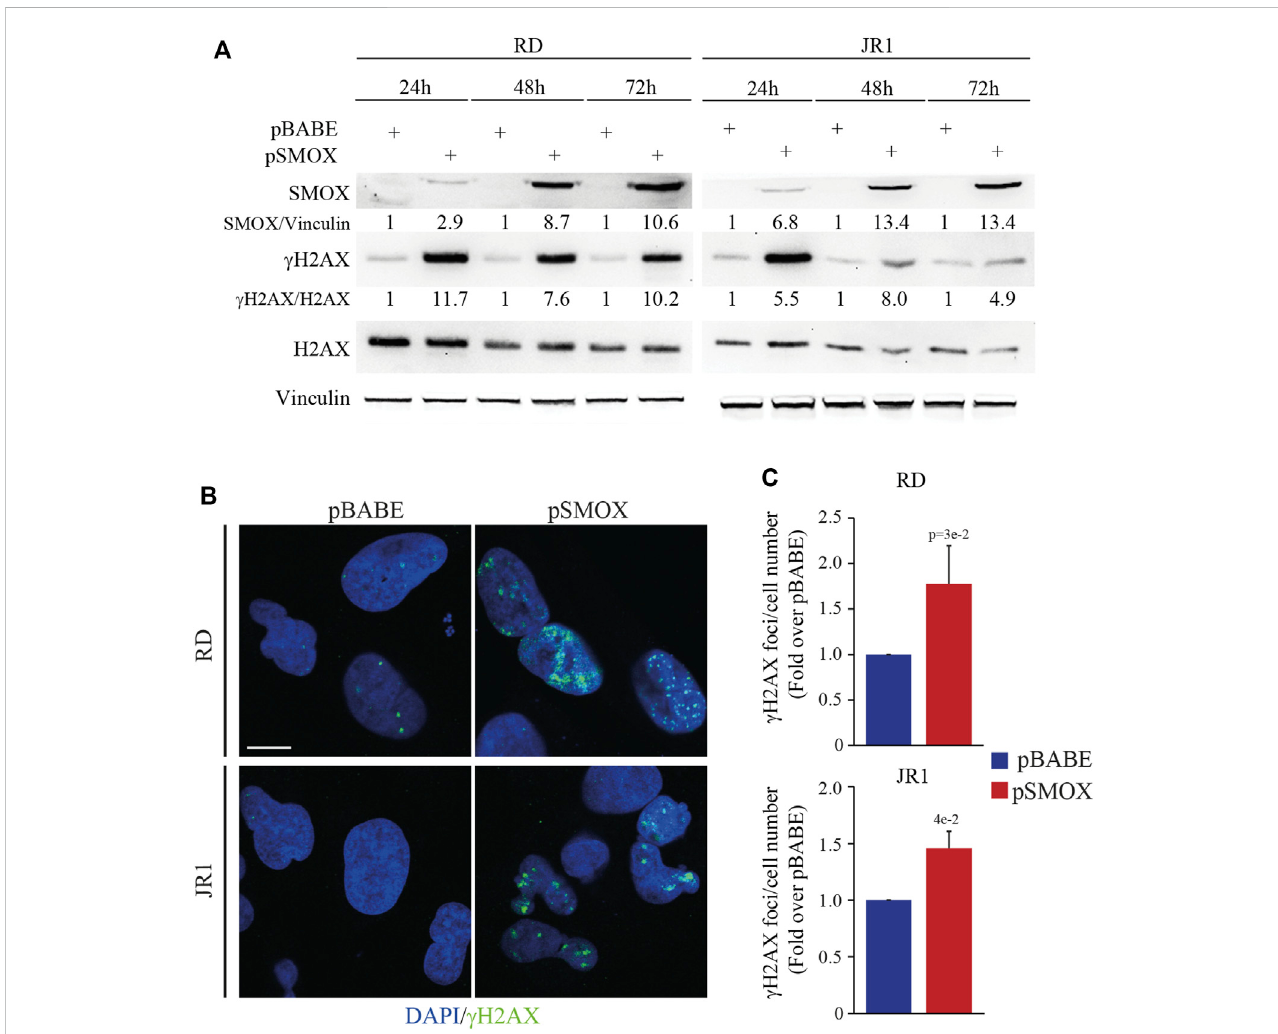
FIGURE 5 SMOX overexpression in FN-RMS cell lines inducesDNA damage. (A) Representative western blot ( n = 3independentbiologicalreplicates) depicting the inductionofDNAdamageonSMOXoverexpressing-RDand-JR1cellsatthereportedtimepoints.SMOX, γ H2AXandtotalH2AXproteinlevelsweredetected. SMOX and γ H2AX levels were normalized to Vinculin and total H2AX protein levels, respectively, and expressed as fold increase over pBABE values. (B) Representative immuno fl uorescenceimagesof γ H2AX(green) ( n =3independentbiological replicates) inSMOX overexpressing-RD and -JR1 cells 24 h post infection. DAPI (blue) was used as nuclear counterstain. Images were taken using confocal microscopy with a ×60 oil immersion objective lens. Scale Bar = 10 μ m. (C) Histograms γ H2AX foci per cell number in RD and JR1 after 24 h of SMOX overexpression and expressed as fold increase over pBABE values. Graph represents the mean of three independent experiments ±SD, Student two-tailed t -Test. Exact p -values are reported in the fi